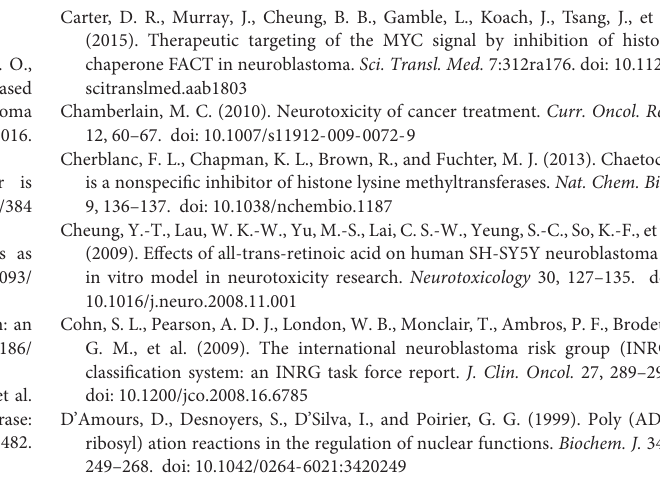
(A) Kaplan-Meier survival curves showing the predictive strength of the expression levels of SMARC genes in neuroblastoma tumours on patient outcome. The SMARCs shown were predicted to be upstream regulators of MYCN’s genomic targets (ChIP-seq). SMARCA1and SMARCD3 was also a direct MYCN target (ChIP-seq). All survival curves were generated using the SEQC (Zhang et al., 2015) 498 neuroblastoma tumour dataset in the R2: Genomics Analysis and Visualization Platform (http://r2.amc.nl). (B) Gene expression levels of MYC family gene members in the IMR32 cell line, as assessed by RNA-seq (Duffy et al., 2015) (C) Cell viability assessment for IMR32 cells upon treatment with SGC library compounds. Compound dilutions are indicated above histograms (1x, 0.1x or 0.01x). Treatment bars – viability upon 48 h treatment. Washout bars – viability 72h upon washout, relative to corresponding untreated control at the same time point. Error bars indicate the mean ± SD. Supplementary Figure 2 | Additional expression and post-treatment imaging data. (A) CBP (CREBBP) transcript expression across the 39 neuroblastoma cell lines and two control non-neuroblastoma samples (human foetal brain tissue and a retinal pigment epithelial cell line, RPE1 cells) profiled by RNA-seq by Harenza et al. (2017), expression measured in FPKMBs. (B) Images of IMR32 cells after 48 h treatment with 1x dilution of epigenetic targeting compounds. Images were taken with 40x magnification. (C) Images of IMR32 cells after 72 h treatment with decitabine (5-aza-dC). (D) Kaplan-Meier survival curves showing the predictive strength of the expression level of SMYD2 in neuroblastoma tumours on patient outcome. Survival curve was generated using the SEQC (Zhang et al., 2015) 498 neuroblastoma tumour dataset in the R2: Genomics Analysis and Visualization Platform (http://r2.amc.nl). Supplementary Figure 3 | Additional network, outcome and viability data. (A) Protein-protein interaction network of the epigenetic MYCN interactome hits, and the MYCN protein, as generated by STRING (https://string-db.org/). Epigenetic hits were generated by overlapping our previously published MYCN mass spectrometry protein-protein interactome (Duffy et al., 2015, 2016) with epigenetic gene lists from Miremadi et al. (2007) and EpiDBase (Loharch et al., 2015) ( Supplementary Table 1 ). (B) Kaplan-Meier survival curves showing the predictive strength of the expression levels of the CREB1, EP300 and BRD4 genes in neuroblastoma tumours on patient outcome. All survival curves were generated using the SEQC (Zhang et al., 2015) 498 neuroblastoma tumour dataset in the R2: Genomics Analysis and Visualization Platform (http://r2.amc.nl). (C) Log 10 relative viability (Alamar Blue assay) upon 48 h combination CBP and BRD4 inhibitor treatment (C646 and JQ1) of MYCN amplified induced (Dox + ) and non-induced (Dox − ) SY5Y-MYCN cells. Error bars indicate the mean ± SD. Supplementary Figure 4 | Additional phenotypic screen data. (A) Zebrafish embryos treated for 24 h (28 h post fertilisation [hpf]- 52 hpf) with epigenetic targeting compounds (IBET-151, I-CB112 and CBP30). Magnification is 10x, images from 52 hpf. Melanocytes appear black due to their endogenous melanin. Otic vesicles (large black circles) mark the anterior pole (head) of the